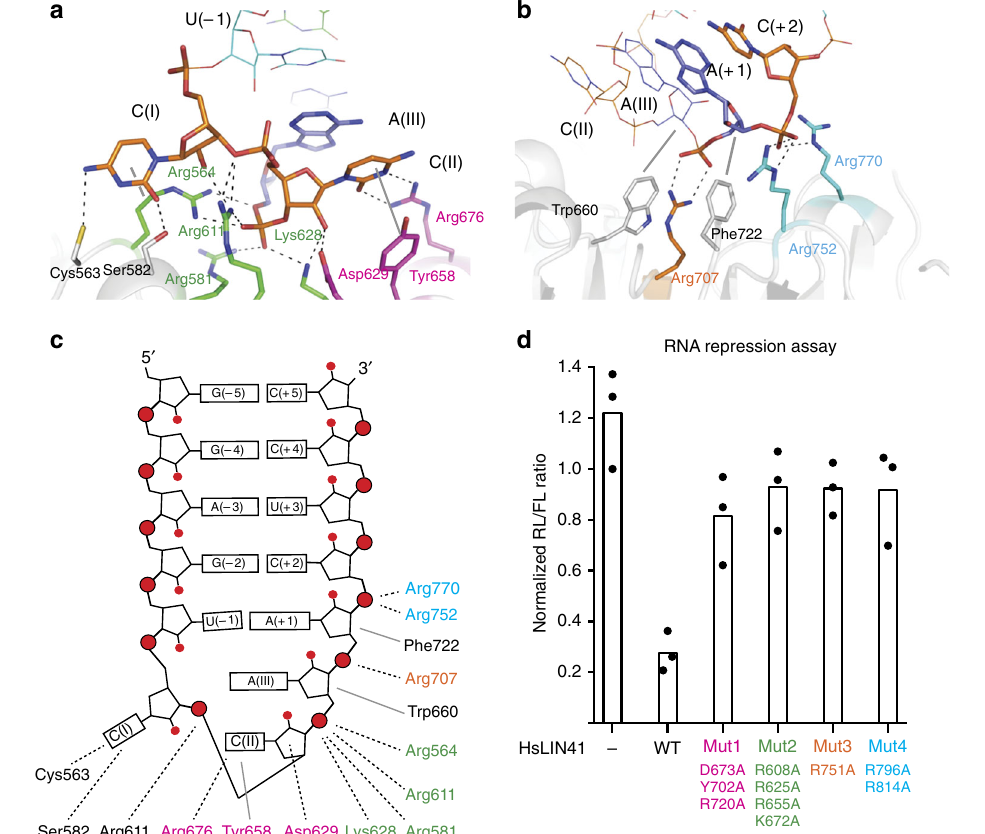
Fig. 5 Molecular interactions underlying LIN41 binding to RNA SLs. a , b Detailed views of interactions between the lin-29A RNA and the DrLIN41 NHL propeller. Nucleotides and protein side chains are highlighted and their directly interacting residues are shown as sticks; the remaining parts are shown as lines (RNA) or ribbons (protein). Hydrogen bonds are presented as dotted lines and hydrophobic interactions as solid lines. Nucleotides are colored as in Fig. 4d, whereas protein side chains are colored according to the mutational analysis. c Schematic representation of the lin-29A RNA hairpin and of its interactions with DrLIN41 NHL residues (type of interaction and color code as in a , b ). d Expression of mutant HsLIN41 proteins did not severely down- regulate Renilla luciferase (RL) reporter expression unlike the wild-type HsLIN41, when a fragment corresponding to the mab-10 condensed 3 ′ -UTR was transplanted into an unregulated 3 ′ -UTR of the reporter construct. Bars in the graph represent the mean between three biological